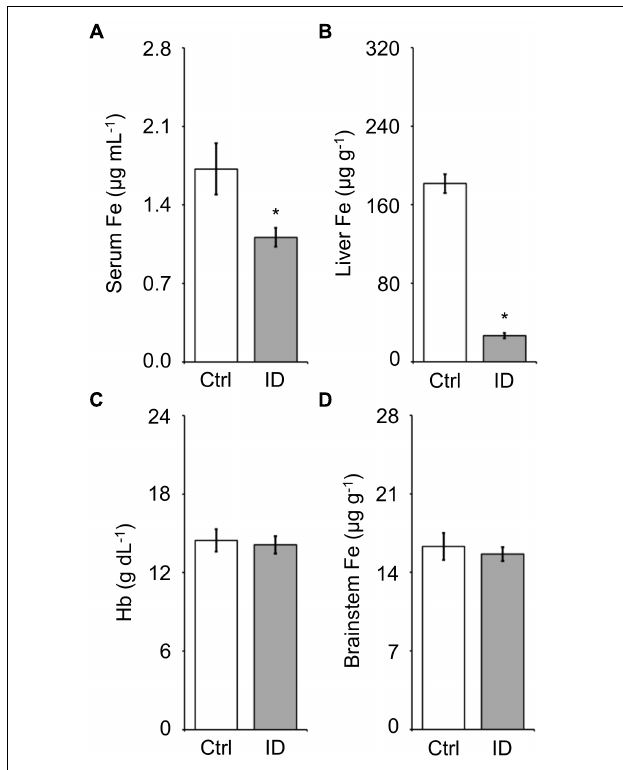
FIGURE 6 | Values of iron (Fe) concentration measured in serum (A) , liver (B) , and brainstem (D) and of blood hemoglobin concentration (C) in the mice fed control diet (Ctrl) or iron-deficient diet (ID). Data are means ± SEM with n = 8–11 per group. ∗ P < 0.05 vs. Ctrl ( t